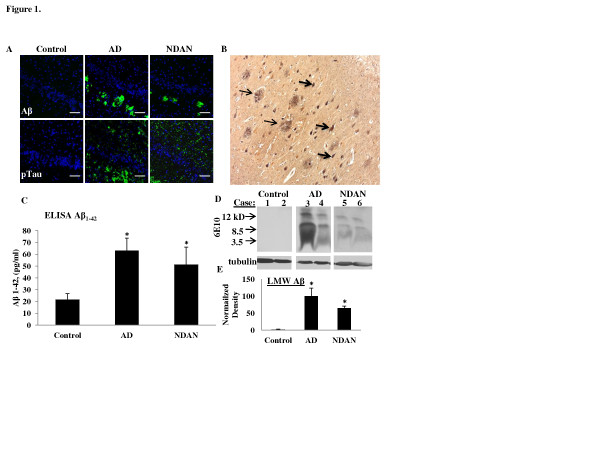
Pathological signatures of AD occur in cognitively intact individuals (NDAN). (A) Immunohistochemical detection shows reactivity for Aβ plaques (top row) and phosphorylated tau (bottom row) in the dentate gyrus of individuals classifed as control (Braak 1, Plaque 3, MMSE 30), AD (Braak 6, Plaque 1, MMSE 2), or NDAN (Braak 6, Plaque 1, MMSE 27). DAPI-containing mounting medium was used to visualize nuclei (blue). 20x magnification, scale bar 100 μm. (B) Bielschowsky staining in the hippocampus of an NDAN individual shows plaques (thin arrows) and neurofibrillary tangles (thick arrows). (C) An ELISA shows increased Aβ1-42 in AD and NDAN hippocampi (n = 3 per group and asterisks (*) denote values significantly higher than control with p < 0.05). (D) Representative Western blot of soluble hippocampal fractions (300 μg) from individual cases probed with 6e10 shows that LMW Aβ species are present in both AD and NDAN. Densitometric analysis (F) of the major bands (monomer at 4kD and dimer at 8.5kD) together shows that AD and NDAN cases are significantly different than control where the average optical density is set at 100; the asterisks (*) denote statistical significance compared to the control value (p = 0.022, ANOVA); The Western blot shown is representative of 9–10 individual cases assayed in each group and experiments were repeated 3 – 4 times